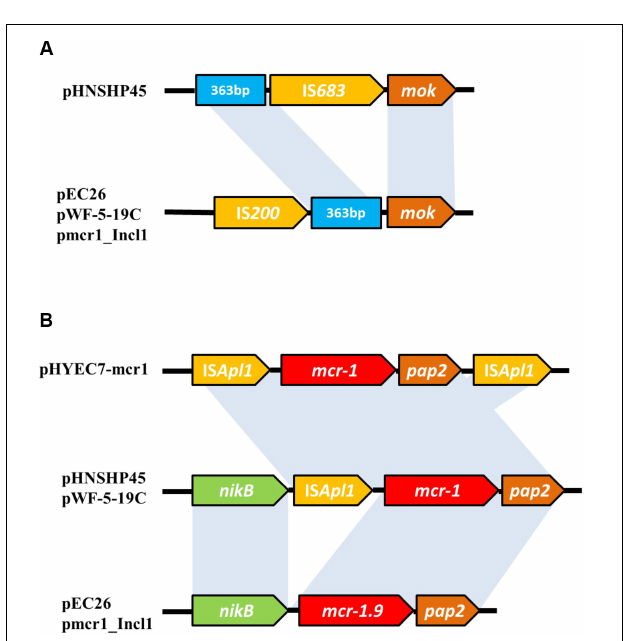
FIGURE 2 | A comparison of the genetic environments of IS683 and IS200 (A) , along with mcr-1 and mcr-1.9 (B) in the plasmids pHYEC7-mcr1 (Li et al., 2017), pHNSHP45, pWF-5-19C, pmcr1_Incl1 and pEC26. Gray shading indicates > 99% nucleotide